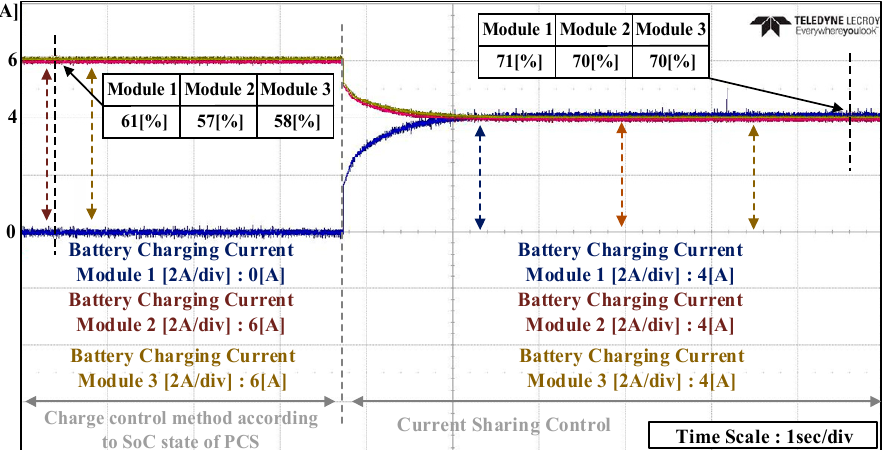
Figure 16. Battery charge current waveform with charge control by SoC state.